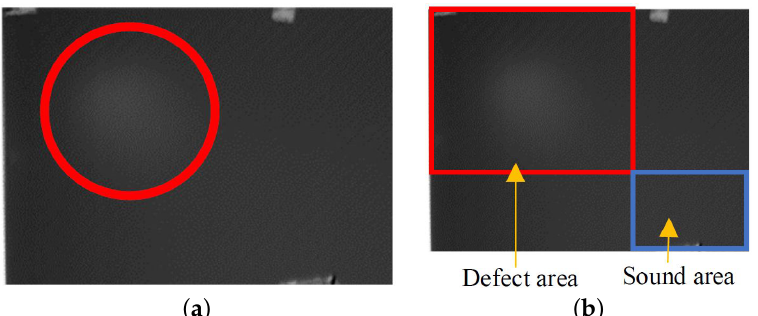
Figure 11. Exemplary results of infrared inspection: ( a ) indication of a defect response, and ( b ) defi- nition of defected and sound